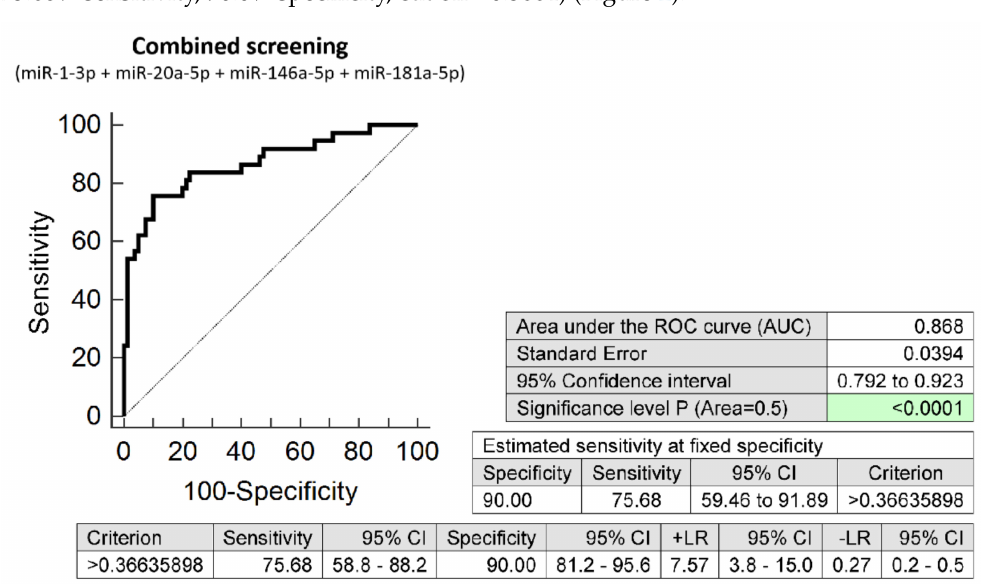
Figure 2. ROC analysis—the combination of microRNA biomarkers. The combination of miR-1-3p, miR-20a-5p, miR-146a-5p, and miR-181a-5p showed that at 10.0% FPR, 75.68% of SGA pregnancies had aberrant microRNA expression profile in the whole peripheral venous blood during the first trimester of